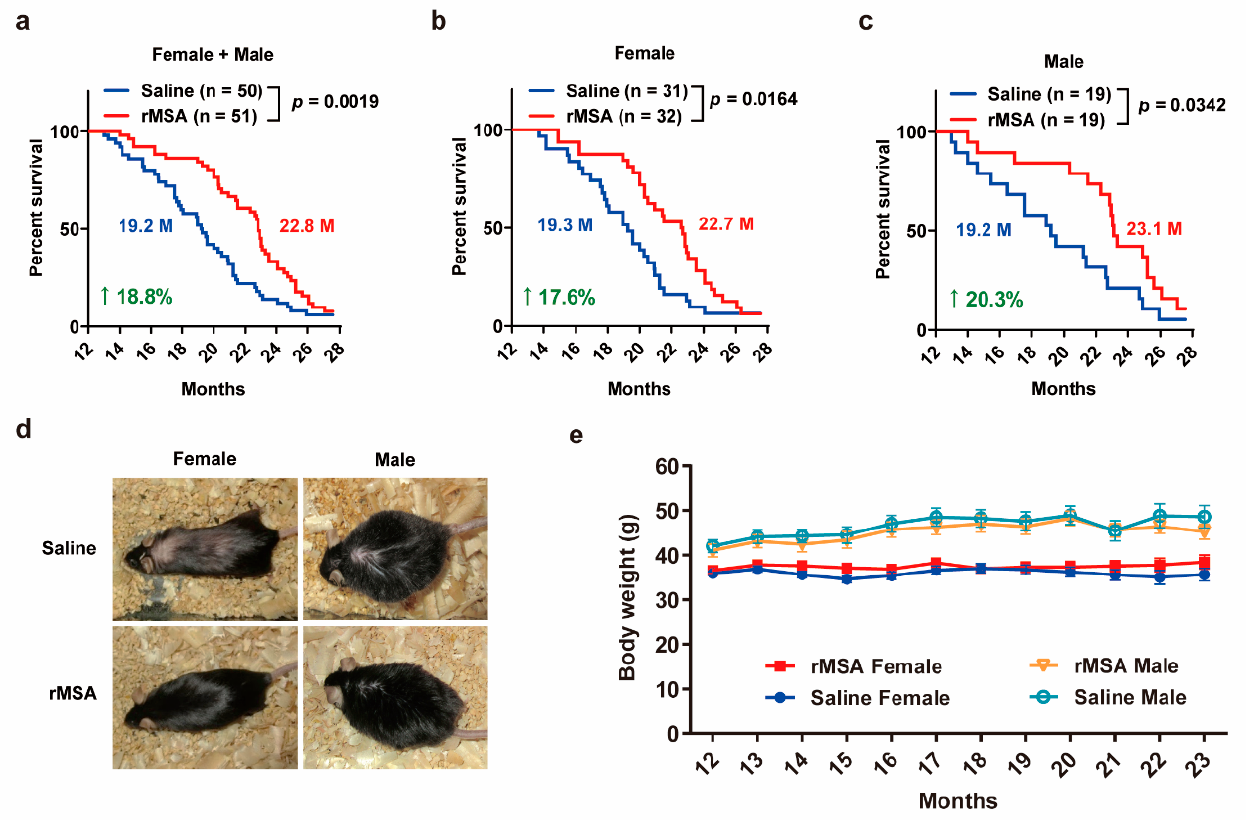
Figure 4. rMSA treatment increased the lifespan in mice. ( a – c ) Overall survival curves of female + male ( a ), female ( b ) and male ( c ) mice treated with 1.5 mg rMSA per gram of body weight or isometric saline every 3 weeks. Median survivals (in months, M) and percentage increases are indicated. p -value was calculated by the log-rank (Mantel-Cox) test. n, number of mice used for each analysis. ( d ) Representative images of aged mice injected with rMSA or saline. ( e ) Body weight of female and male mice treated with 1.5 mg rMSA per gram of body weight or isometric saline every 3 weeks. All graphs represent mean with SEM.